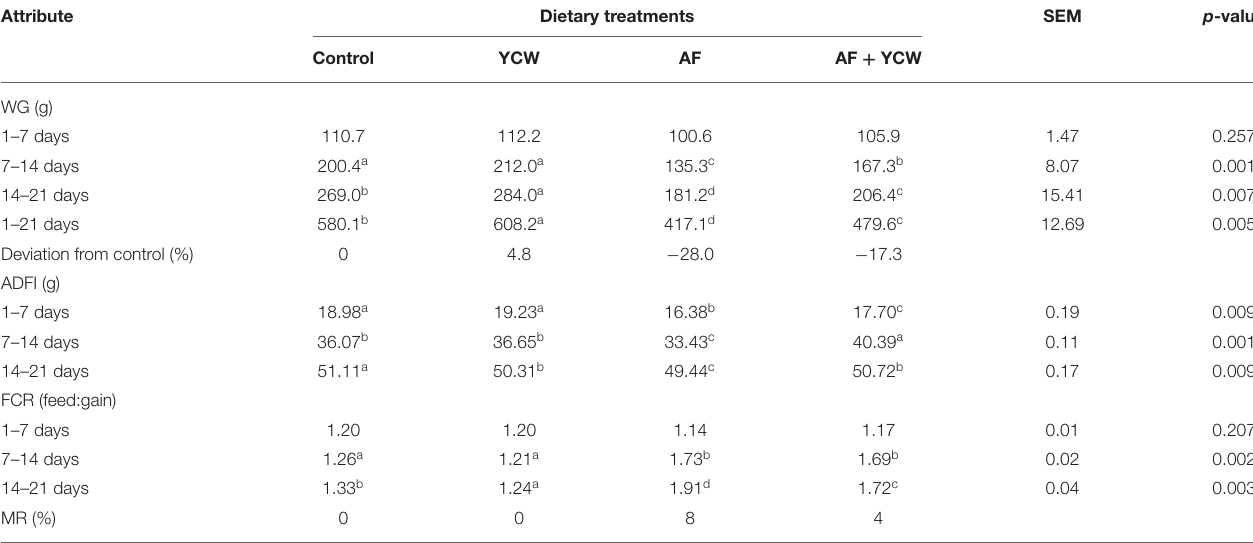
Mean of five replicates of 10 chicks each per treatment (minus mortality). Means, within the same row, not sharing a common superscript differ significantly (Tukey test p < 0.05). WG, weight gain; ADFI, average daily feed intake; FCR, feed conversion ratio; MR, mortality rate.